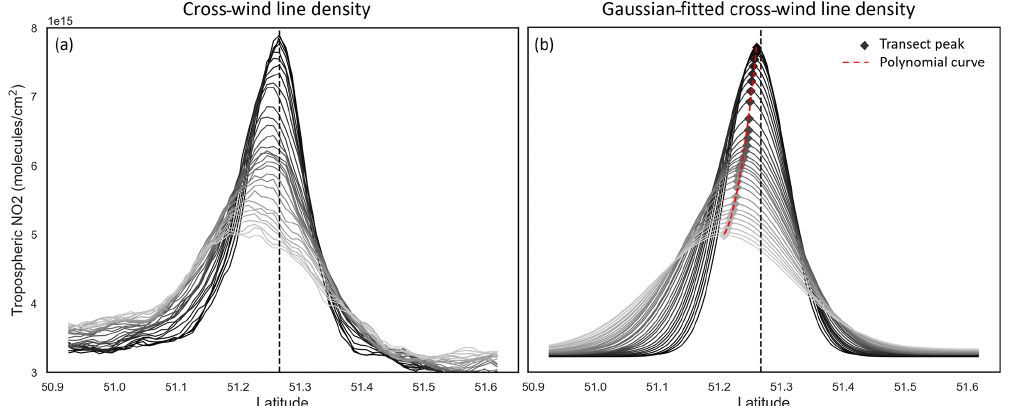
Figure 6. Across-wind line density profiles (a) and Gaussian-fitted line density profiles (b) taken at regular 1km transects for the wind- rotated average of Belchatow power station in Poland. The transect at the origin is given by the black line, with the gradient getting lighter as the distance from the origin increases. Produced using data from May 2018 to November